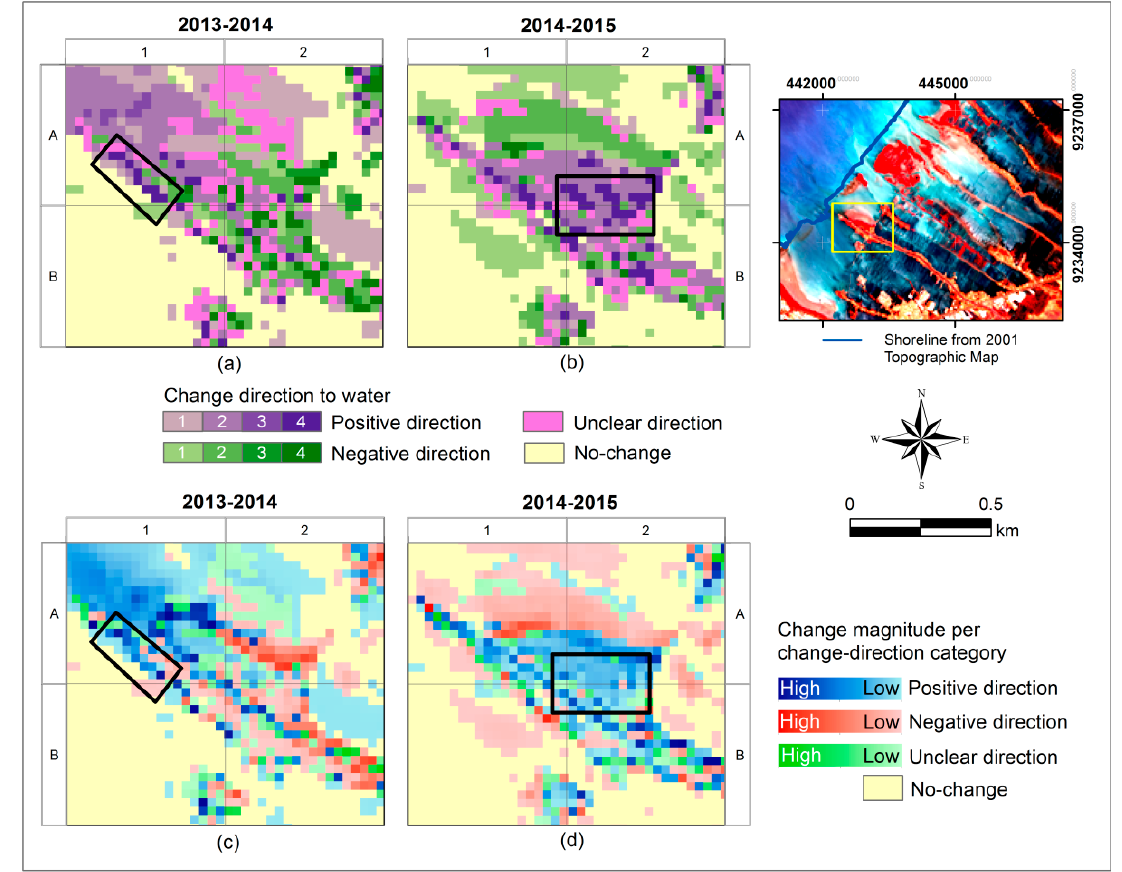
Figure 16. Water membership changes showing a higher change to positive direction (see dark violet pixels in black rectangle sites in ( a , b )) with low change magnitude values (see dark blue pixels in black rectangle sites in ( c , d )).